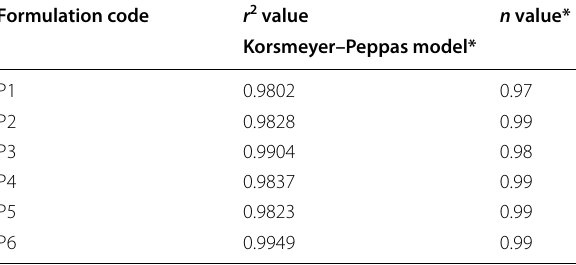
*For drug released within first hour